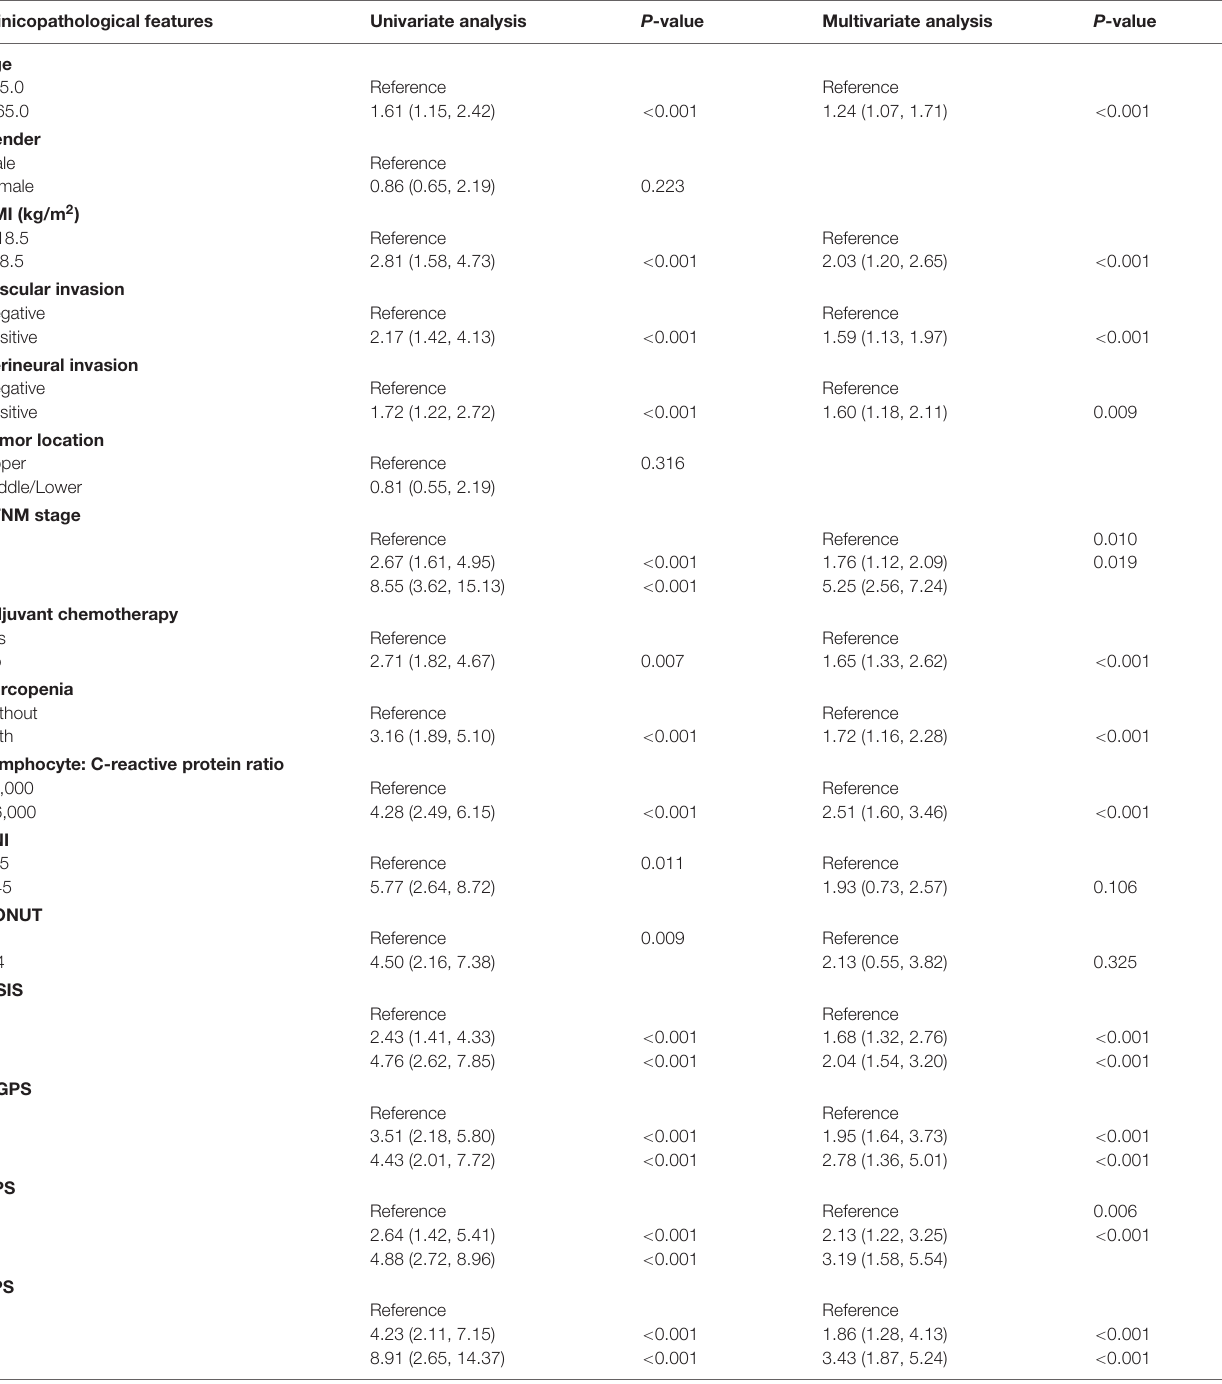
TABLE 3 | Univariate and multivariate analysis of clinicopathological variables in relation to disease-free survival in patients with gastric cancer (discovery cohort). Clinicopathological features Univariate analysis P -value Multivariate